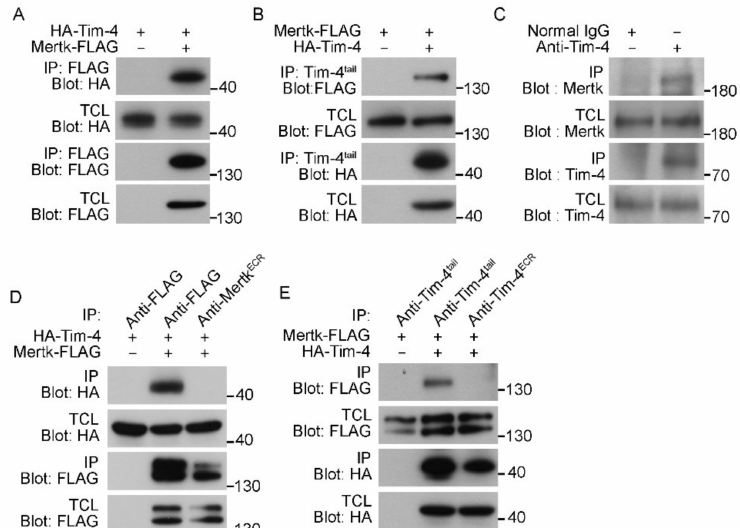
Figure 2. Tim-4 interacts with Mertk. ( A ) 293T cells were transfected with the indicated plasmids. Two days after transfection, the cells were lysed, and FLAG-tagged Mertk was precipitated with anti-FLAG antibody-conjugated agarose beads. Bound proteins were detected with the indicated antibodies ( n = 7). ( B ) The lysates of 293T cells transfected with the indicated plasmids were incubated with an anti-Tim-4 tail antibody and protein A / G agarose beads. Bound proteins were detected by immunoblotting ( n = 3). ( C ) The lysates of peritoneal macrophages were incubated with an anti-Tim-4 tail antibody or a control antibody and protein A / G agarose beads. Co-precipitated Mertk was detected by immunoblotting ( n = 3). ( D , E ) 293T cells were transfected with the indicated plasmids and lysed. Mertk-FLAG (( D ), n = 3) or HA-Tim-4 (( E ), n = 3) in the lysates was precipitated with the indicated antibodies, and bound proteins were detected by immunoblotting. TCL, total cell lysate; IP,